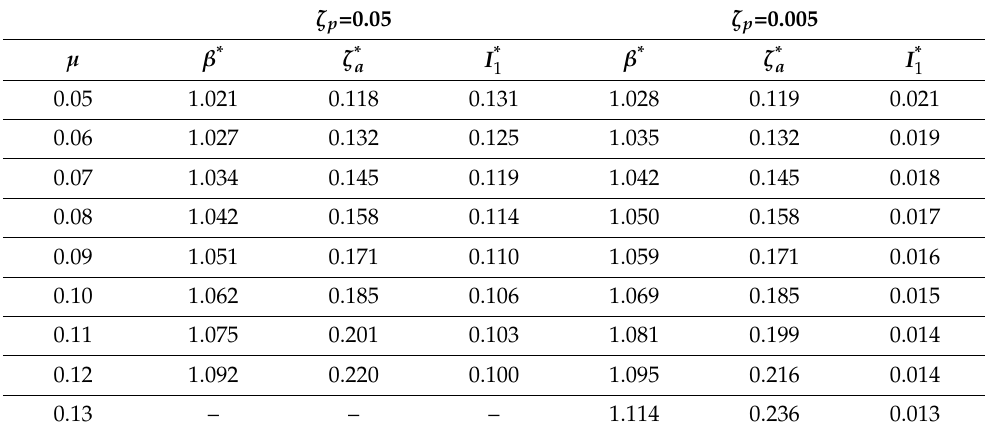
Table 2. The optimum parameters for VS and the corresponding optimum I 1 values when ζ p = 0.05 or ζ p = 0.005. ζ p =0.05 ζ p =0.005